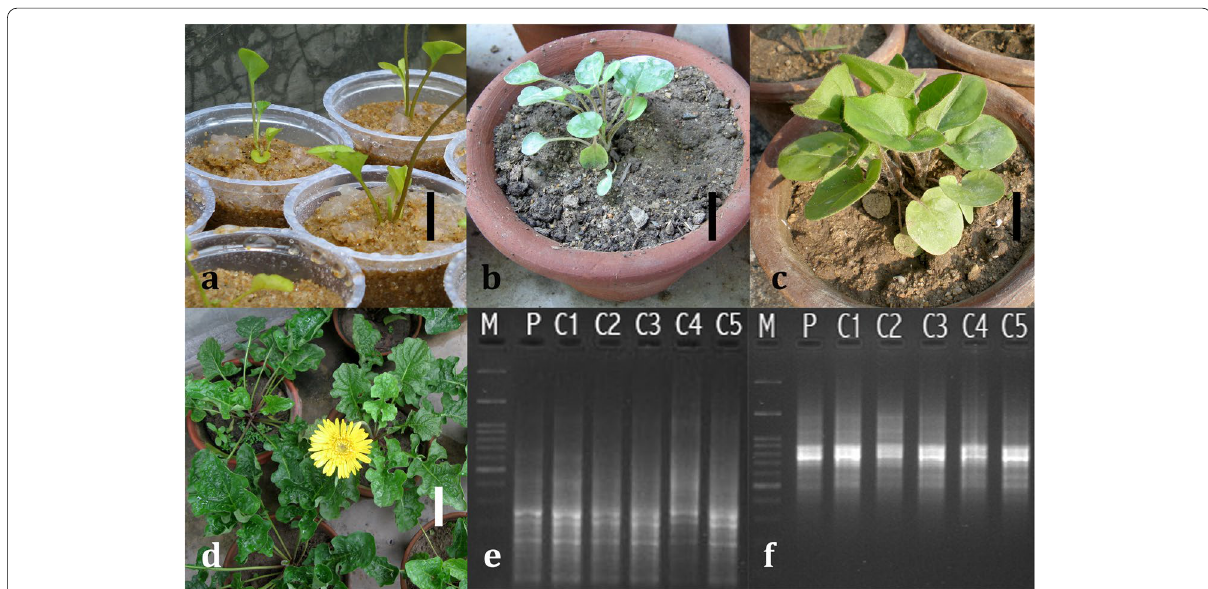
Fig. 2 Acclimatization of in vitro regenerants of gerbera. a Growth status of plantlets after 1 week of primary acclimatization in autoclaved sand ( bar 30 mm); b growth status (with the emergence of new leaves and shoots) of plantlets after 2 weeks of acclimatization in a mixture of sand, = soil, cow urine, and tea leaf waste ( bar 30 mm); c growth status (with the emergence and enlargement of new leaves with elongation of shoots) = of plantlets after 4 weeks of acclimatization ( bar 50 mm); d status of vegetative growth, proliferation, and flowering of acclimatized plantlet after = 6 months of acclimatization in soil ( bar 100 mm); agarose gel electrophoresis of amplified ISSR fragments of regenerants (C1–C5 = from calli and the mother plant (P) exhibiting monomorphic banding pattern e 5 ′ (AG) 8 T3 ′ and f 5 ′ (CA) 8 AG3 ′ lane M